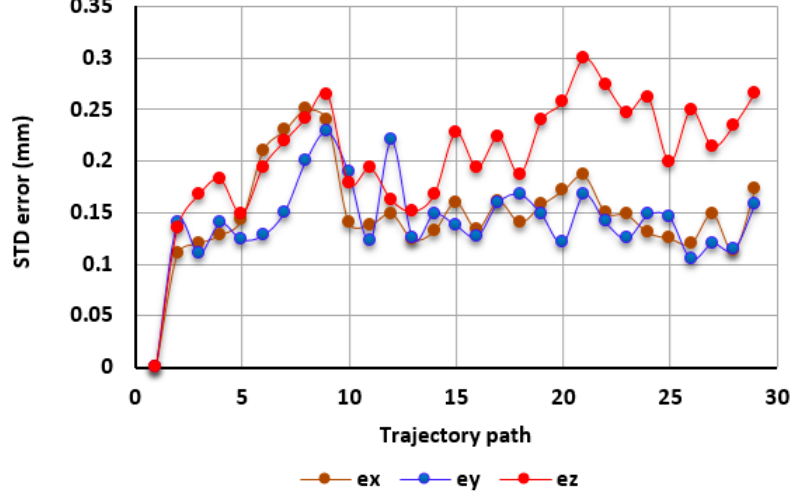
Figure 20. Standard Deviation measured along the robot motion trajectory.